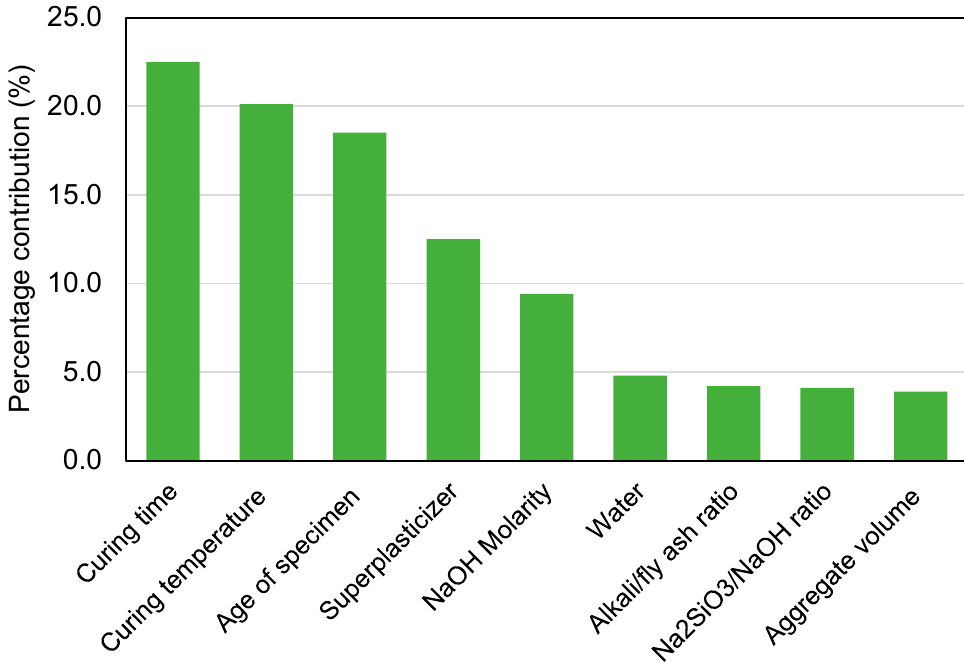
Figure 19. Impact of input factors on the model’s prediction.